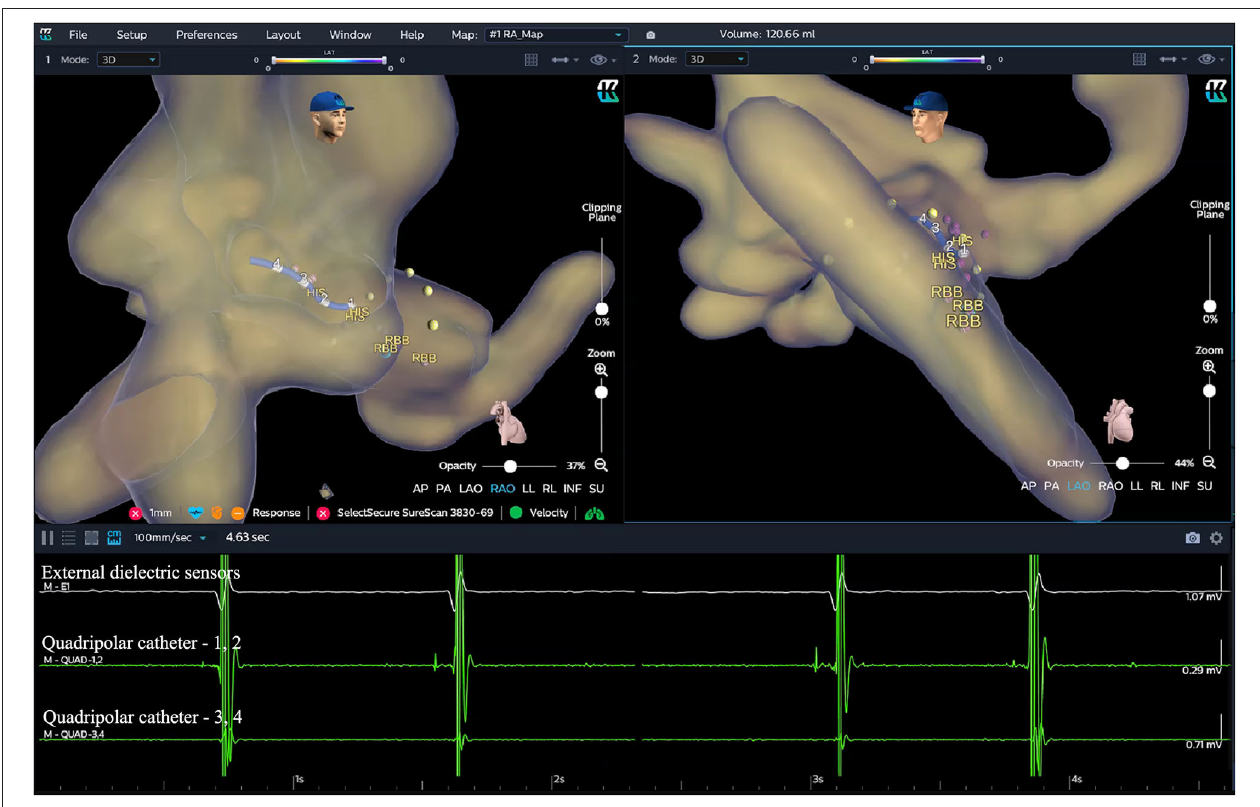
FIGURE 3 | Locating the HB region in the EAM-guided group. Based on the electrical field information, the three-dimensional (3D) cardiac anatomical image was calculated and visualized by moving the catheter without fluoroscopy. The TVA was highlighted (yellow dots in the figure), and the HB region (purple dots in the figure) where the HB potential could be recorded was marked under the guidance of the TVA location. EGMs from top to bottom showed the cardiac signal recorded from the external dielectric sensors, quadripolar catheter 1–2, and quadripolar catheter 3–4, respectively. EAM, electroanatomical mapping; EGM, electrogram; HB, His bundle; RBB, right bundle branch; TVA, tricuspid valve